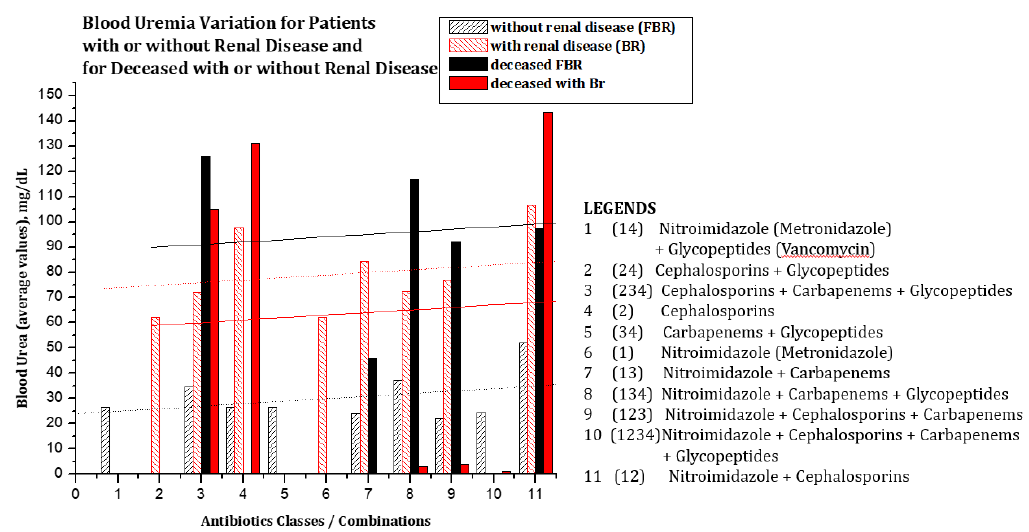
Figure 6. Variation of uremia in digestive disease with renal comorbidity and infection with pathogenic E. coli depending on the antibiotics/antibiotic complexes used, where BR= renal disease and FBR= without renal